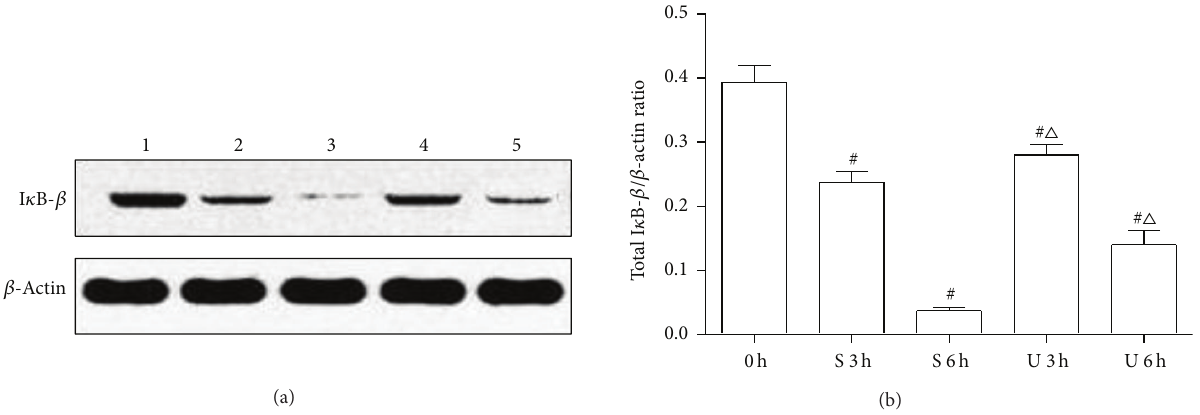
Figure 4: Effects of UTI on inhibition of I 𝜅 B- 𝛽 . (a) Lane 1: C group, lane 2: S group at 3 h, lane 3: S group at 6h, lane 4: U group at 3 h, and lane 5: U group at 6 h. (b) Amount of I 𝜅 B- 𝛽 . 0h = C group; S 3h = S group at 3 h; S 6 h = S group at 6h; U 3 h = U group at 3 h; U 6 h = U group at 6h. # 𝑃 < 0.05 versus C group and △ 𝑃 < 0.05 versus S group at matched